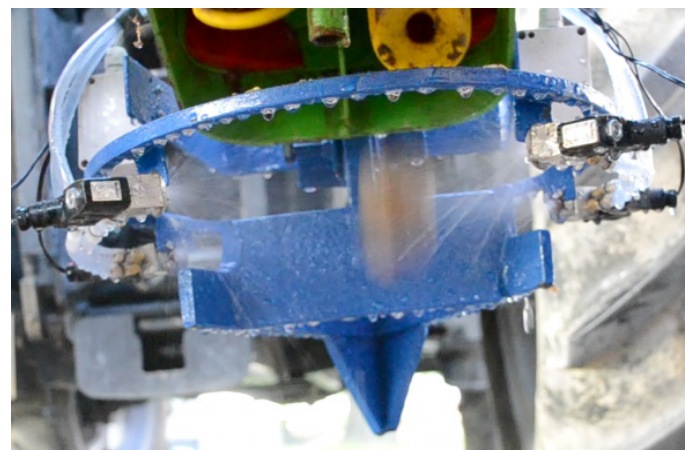
Figure 11. Spraying with a mobile treatment machine. The position of novel solenoid vales with an auxiliary airstream is circled.